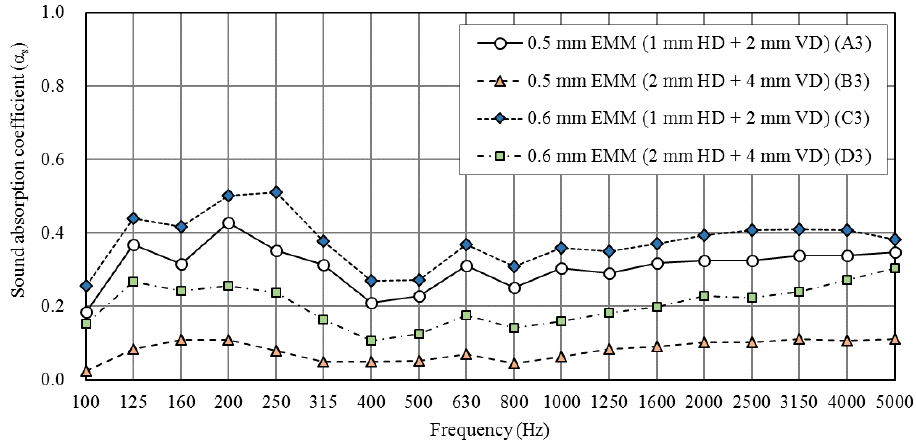
Figure 8. The sound-absorption coefficient of EMM with a 460 mm cavity.